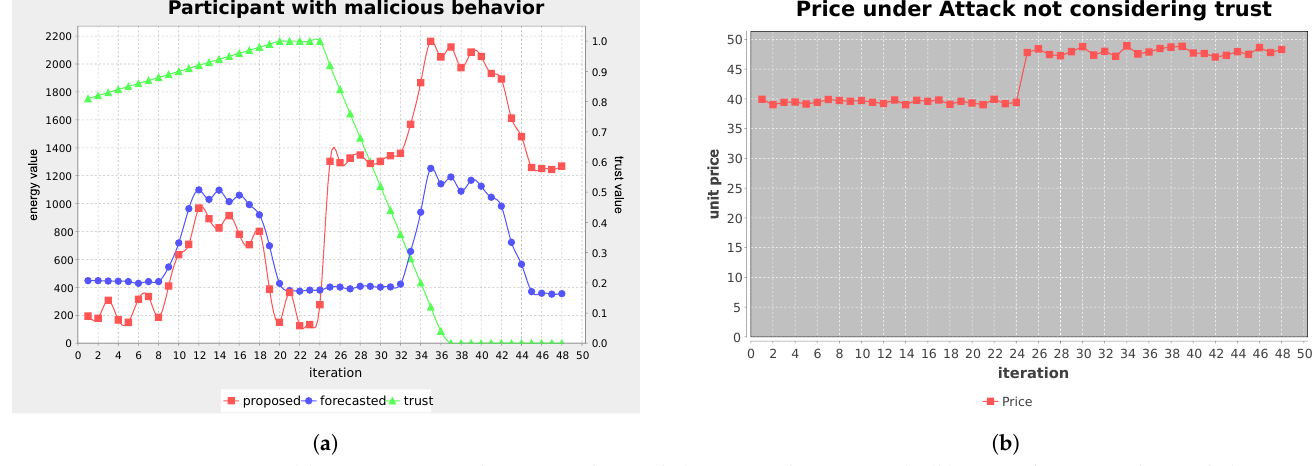
Figure 3. Scenario 2. ( a ) Participant evaluation with attack (not considering Trust); ( b ) Agreed price with attack (not considering Trust).